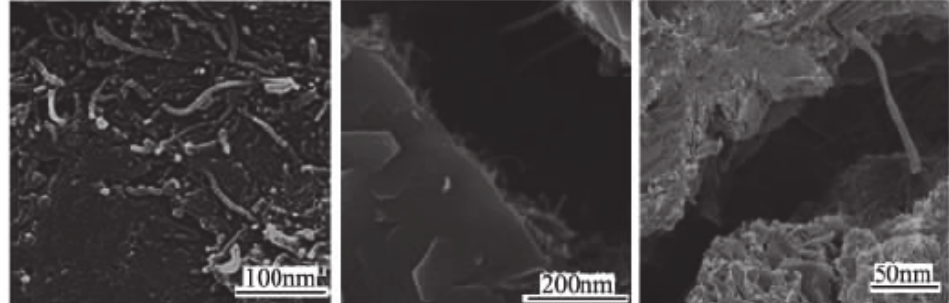
Figure 8: The observation results of carbon nano-tubes under a